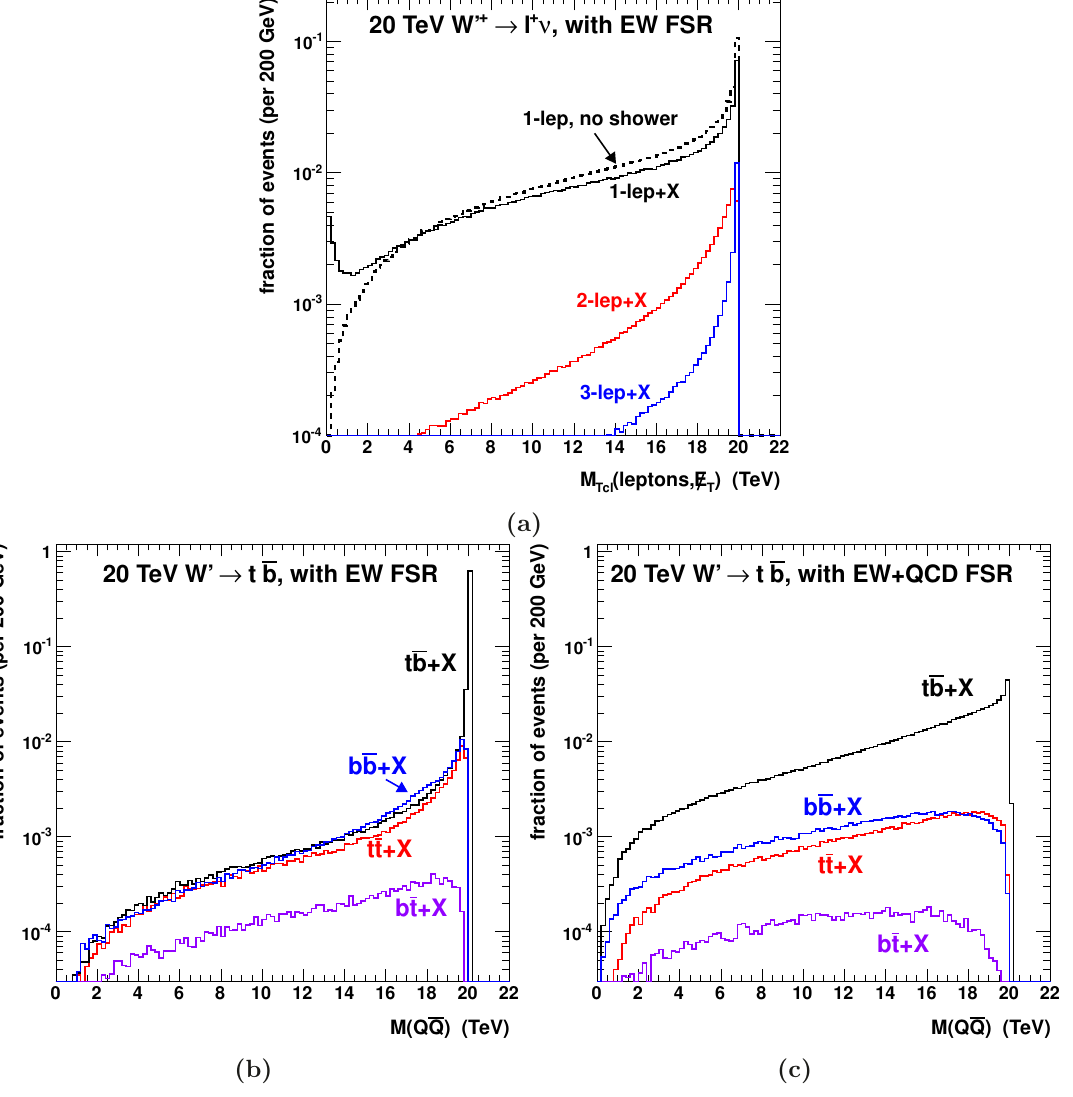
Figure 10. Showered events from 20 TeV W ′ + decays. (a) W ′ + tributions, running the full EW shower and breaking down the signal by inclusive lepton multiplicity (solid curves), as well as the uncorrected two-body decay result (dotted curve). (b) W ′ + quark-pair invariant mass distributions, running the full EW shower, and (c) combining EW and QCD